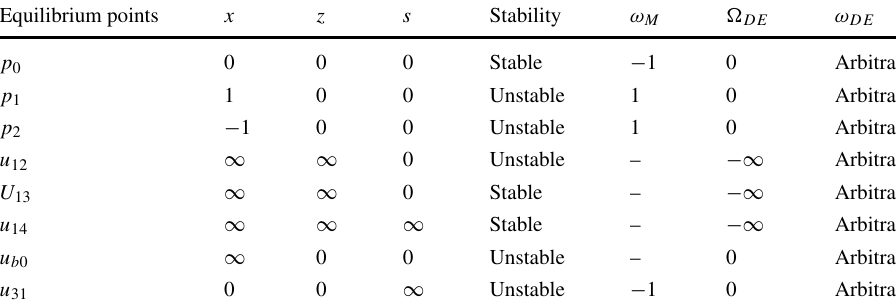
Table 6 Equilibrium points and their characteristics in the interior of the region R 1 for all s ∈